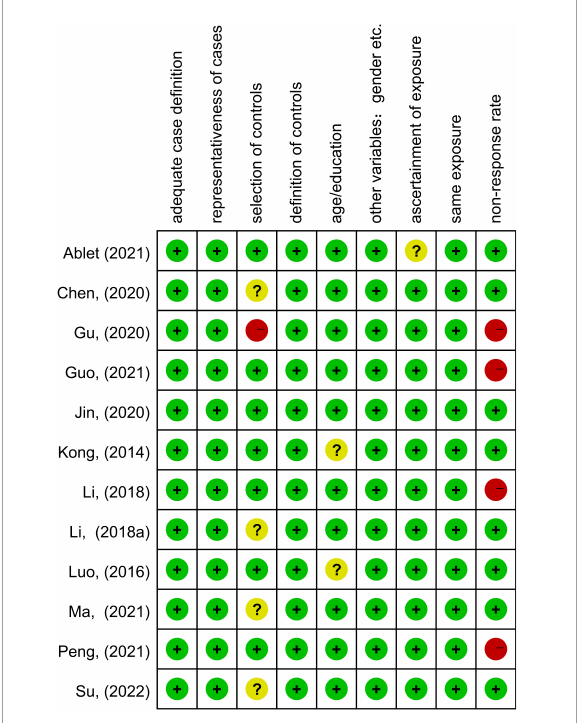
FIGURE2 Summary of risk of bias for included studies according to the Newcastle-Ottawa scale